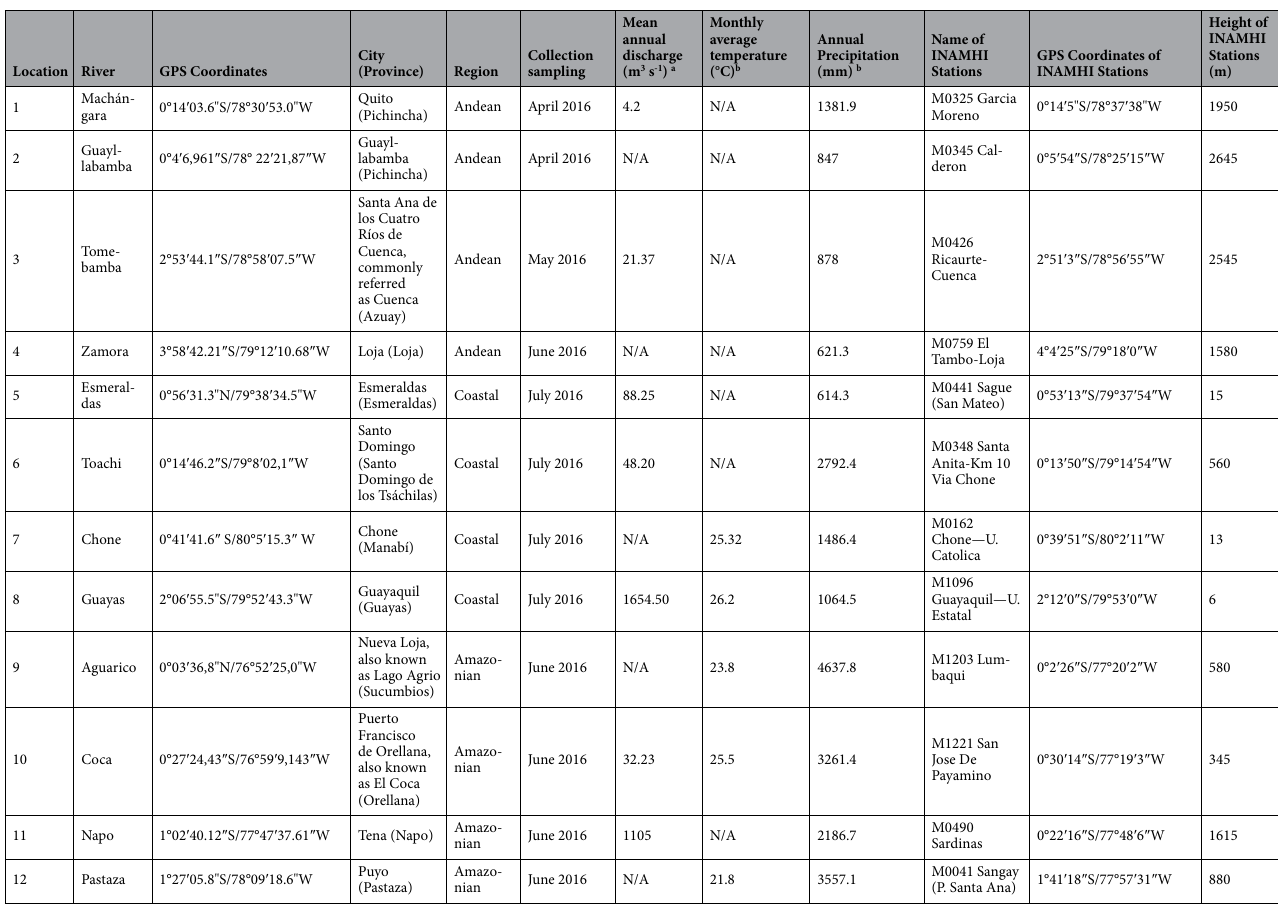
Table 1. Selection of the main Ecuadorian rivers and their collection samples for microbial, physicochemical, and metal analysis in this study. a Data from the National Institute of Meteorology and Hydrology (INAMHI, http:// www. servi ciome teoro logico. gob. ec/); b INAMHI. (2013). Anuario Metereológico. Retrieved from: https:// www. servi ciome teoro logico. gob. ec/ docum_ insti tucion/ anuar ios/ meteo rolog icos/ Am_ 2013. pdf; N/A: Not available.